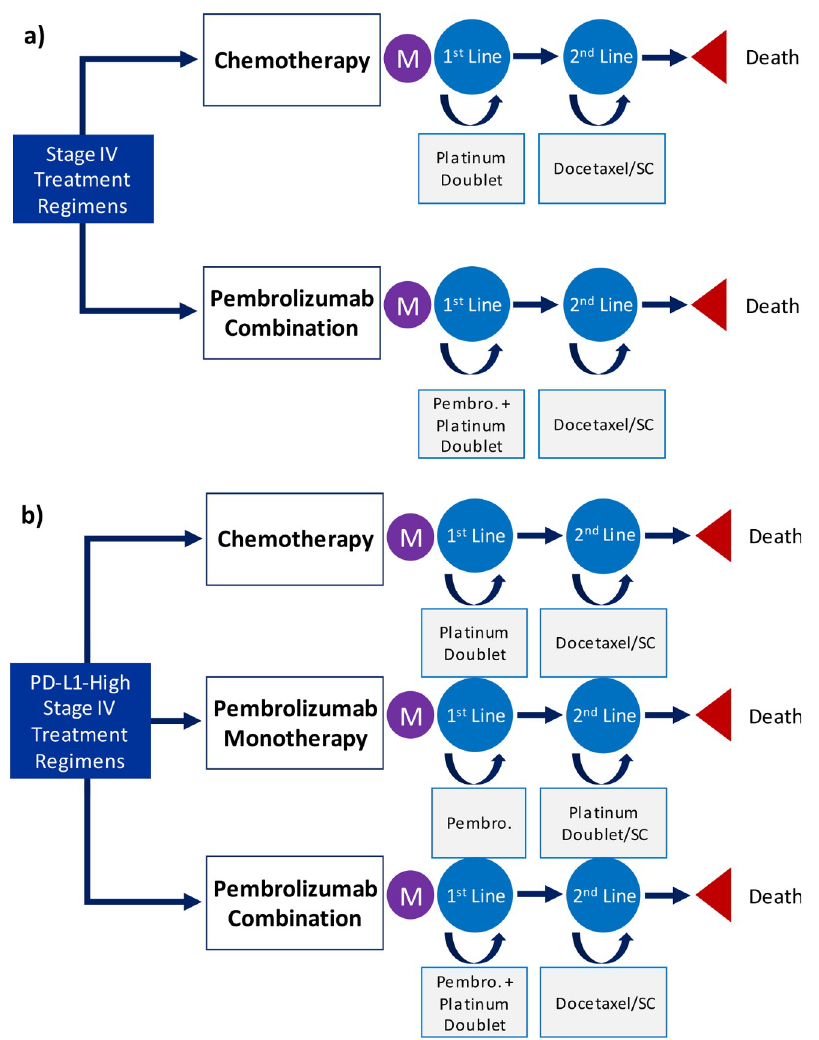
Fig 1. Summary schematic of model structures. a)Pembrolizumab combination therapy model b)Pembrolizumab for PD-L1-high patients model M, Markov node; 1 st Line, first-line treatment; 2 nd Line, second-line treatment; Pembro., pembrolizumab; SC, supportive